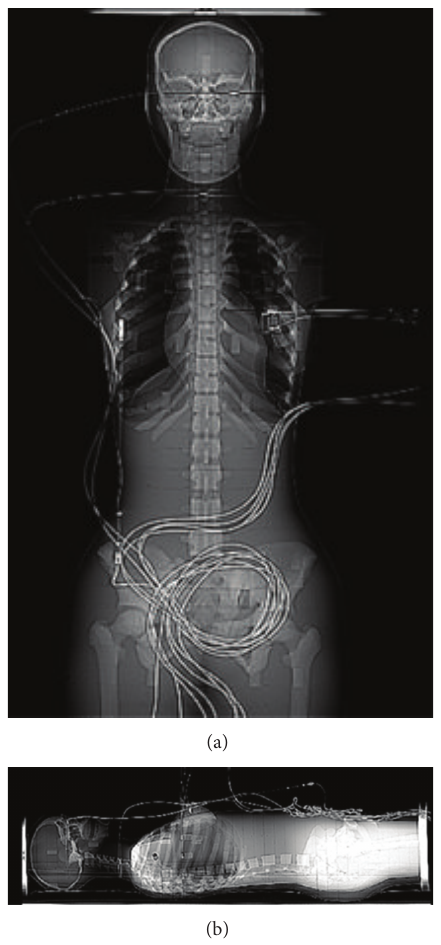
Figure 2: Phantom in supine and lateral view with detectors